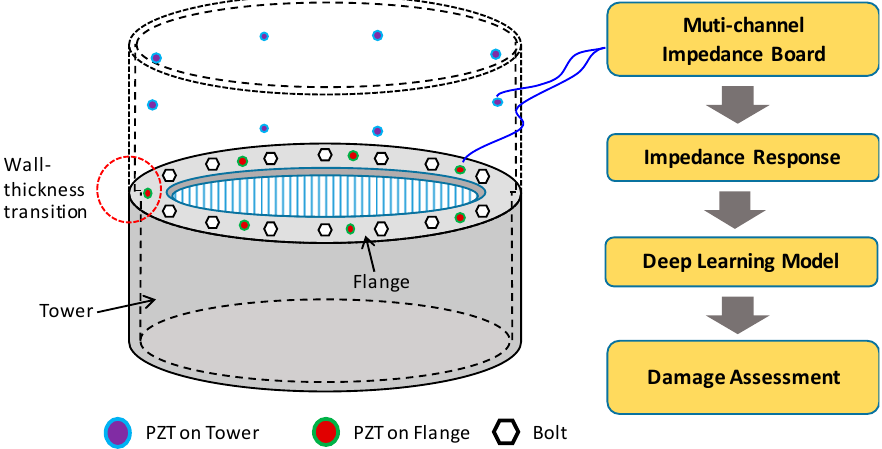
Figure 19. An example of PZT deployment on the tower for impedance-based SHM.